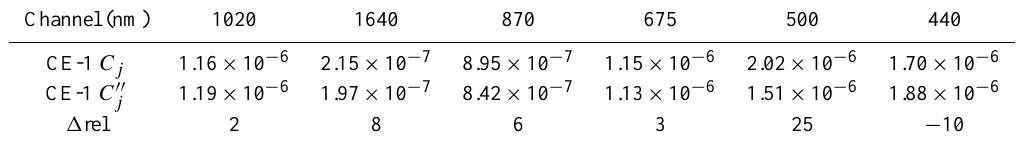
Table 6. Master sky calibration coefficients C j calculated using an integrating sphere and C 00 determined, both in Wm − 2 nm − 1 DC − 1 . The spectral relative variation between both coefficients ( 1 rel in %) is included.